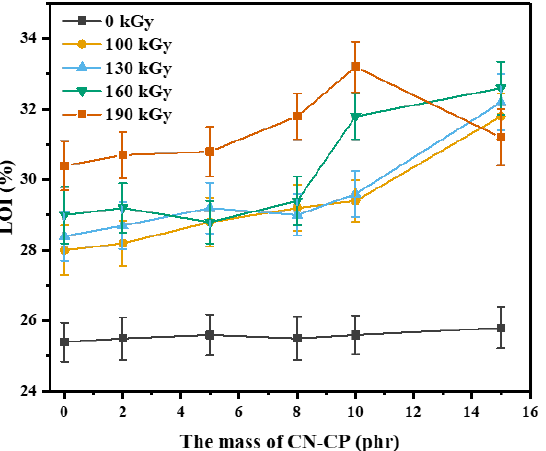
Figure 7. Limiting oxygen index (LOI) of the composites under different irradiation doses.